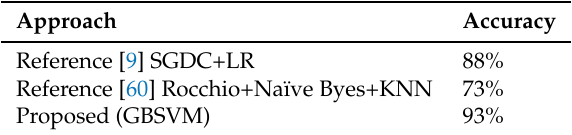
Table 7. Performance comparison of the proposed approach.